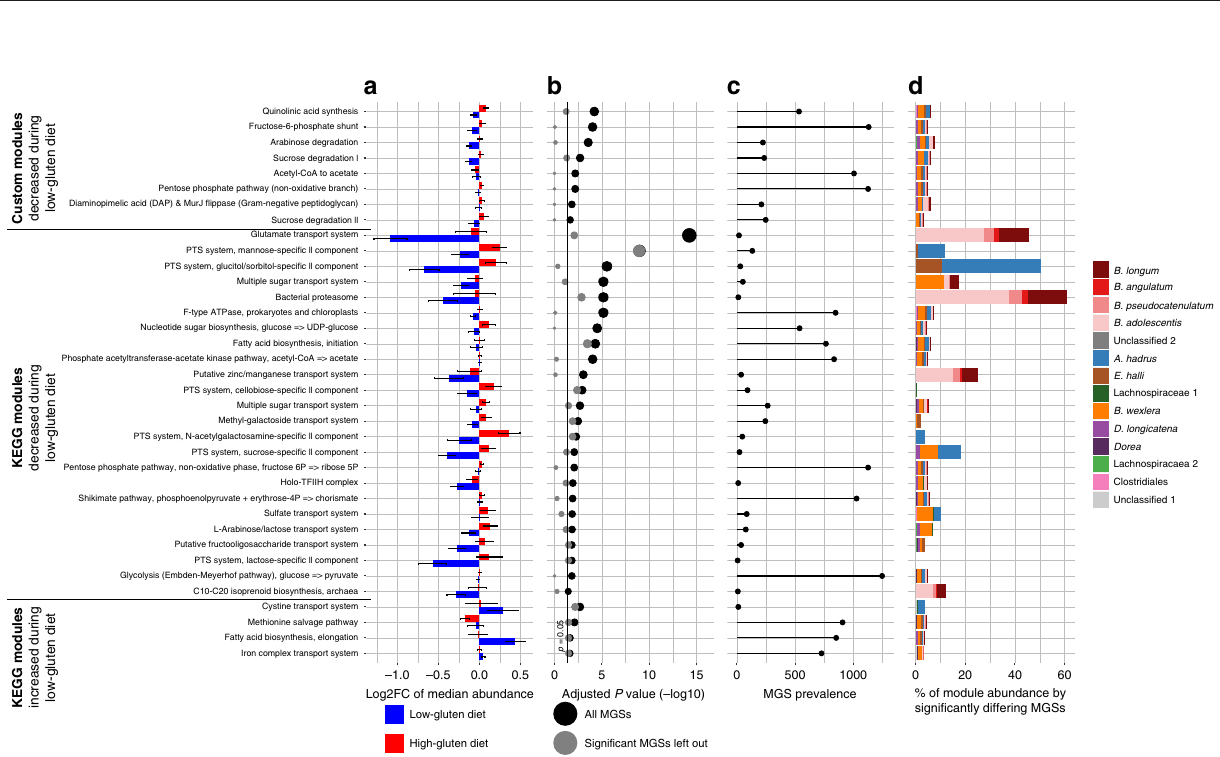
Fig. 2 A low-gluten diet alters the composition of the gut microbiome. a Scatterplot of the statistical signi fi cance of the metagenomic species (MGSs) as assessed by a linear mixed model testing for the difference between the low-gluten and the high-gluten diets adjusted for age, gender, intestinal transit time, participant ( n = 51) and carry-over effect. Adjusted P values are displayed on the y -axis (log10 scale) and the effect size (absolute values were log10 transformed) is on the x -axis. Points are sized according to the total abundance (%) and coloured according to the ten most abundant taxonomic families. The ‘ Other ’ category consists of the remaining families. The horizontal line represents an adjusted P value of 0.05 and the 14 species that changed signi fi cantly (FDR < 0.05) between the interventions are labelled with their full taxonomic annotation. Only species that could be annotated to family level and with abundance above 0.02% were included in the plot (255 species). b Bar chart of the 14 signi fi cant species showing the log2 fold change (means ± SEM) between baseline and after the low-gluten diet (blue bars) and high-gluten diet (red bars), respectively. The black circles are sized according to the negative log10 of the adjusted P values of comparison between the low-gluten and the high-gluten diet using a linear mixed model adjusted for age, gender, intestinal transit time, participant ( n = 51) and carry-over effect. Green circles are scaled according the species abundance. The last column lists the number of participants in whom the given species were measured. Details on the individual species can be found in Supplementary